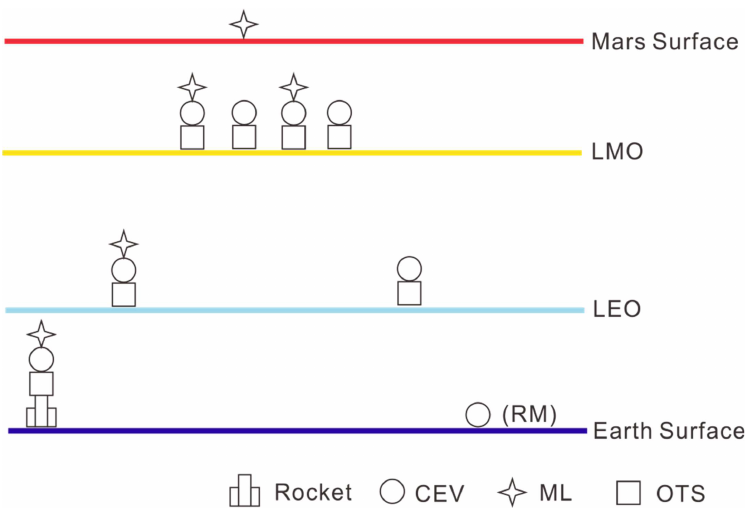
Figure 10. Schematic of